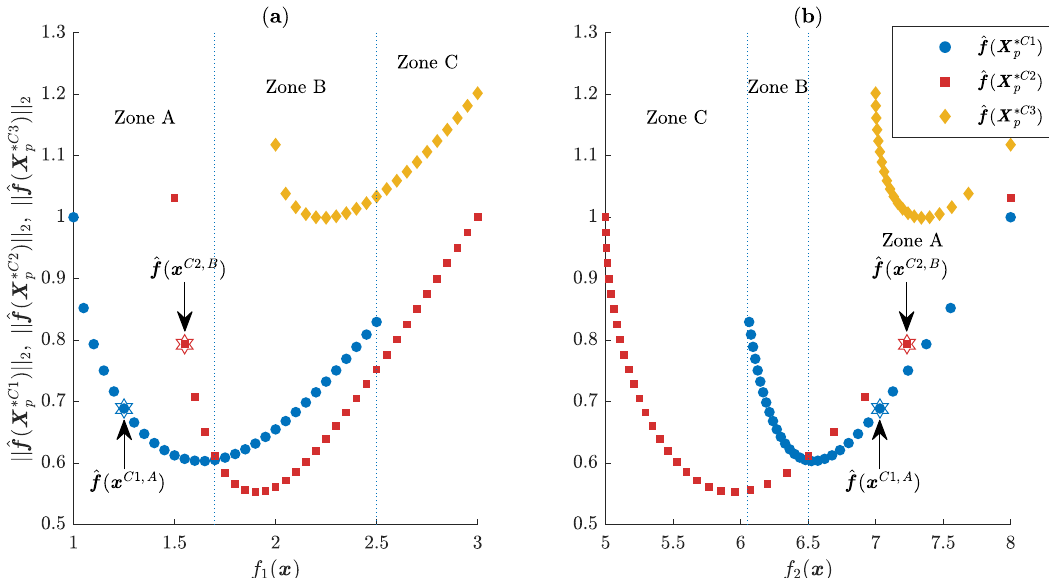
Figure 6. Comparison of design concepts 1, 2, and 3 by employing level diagrams (LDs) with the Euclidean norm. ( a ) LD graph for objective f 1 ; and ( b ) LD graph for objective f 2